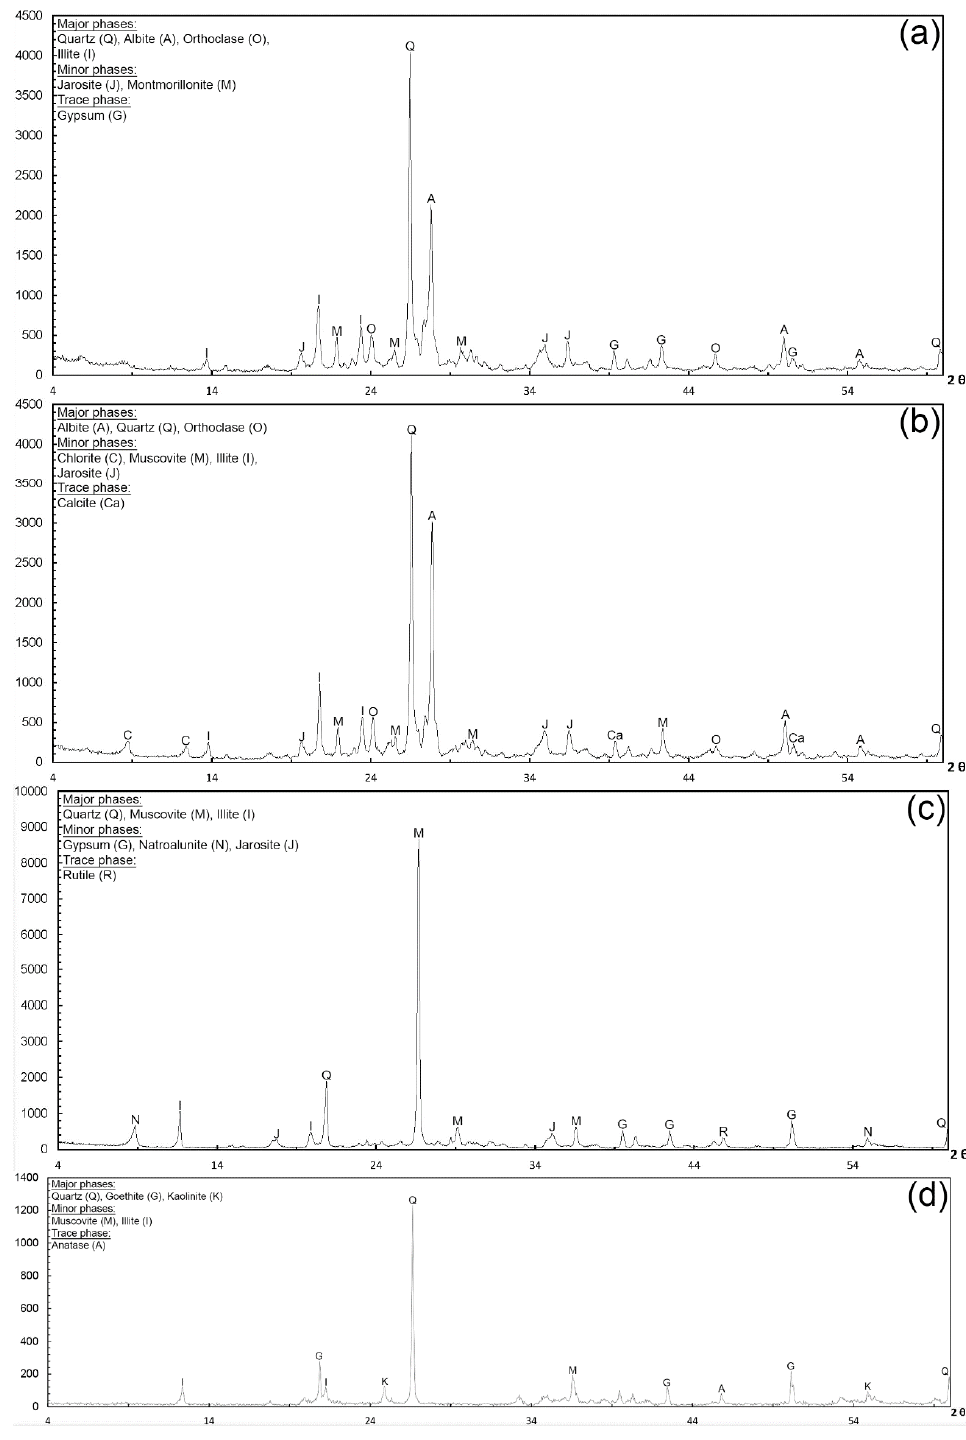
Figure 14. Results of the XRD analysis showing the indicative minerals of the representative samples collected from (a) argillic zone; (b) propylitic zone; (c) phyllic zone; and (d) gossans.